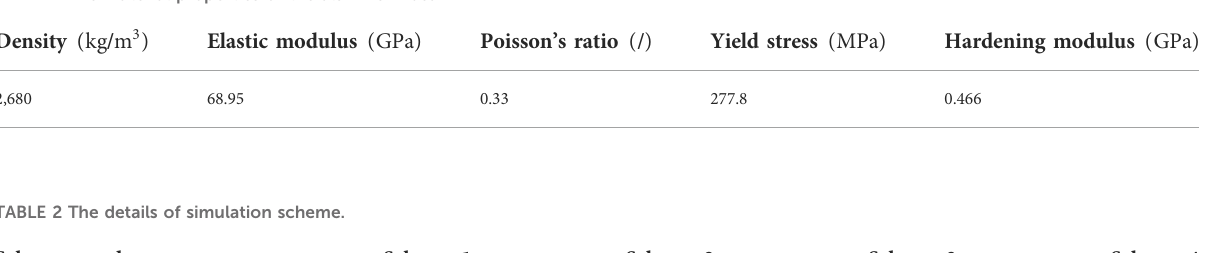
TABLE 1 The material properties of the aluminum beam.